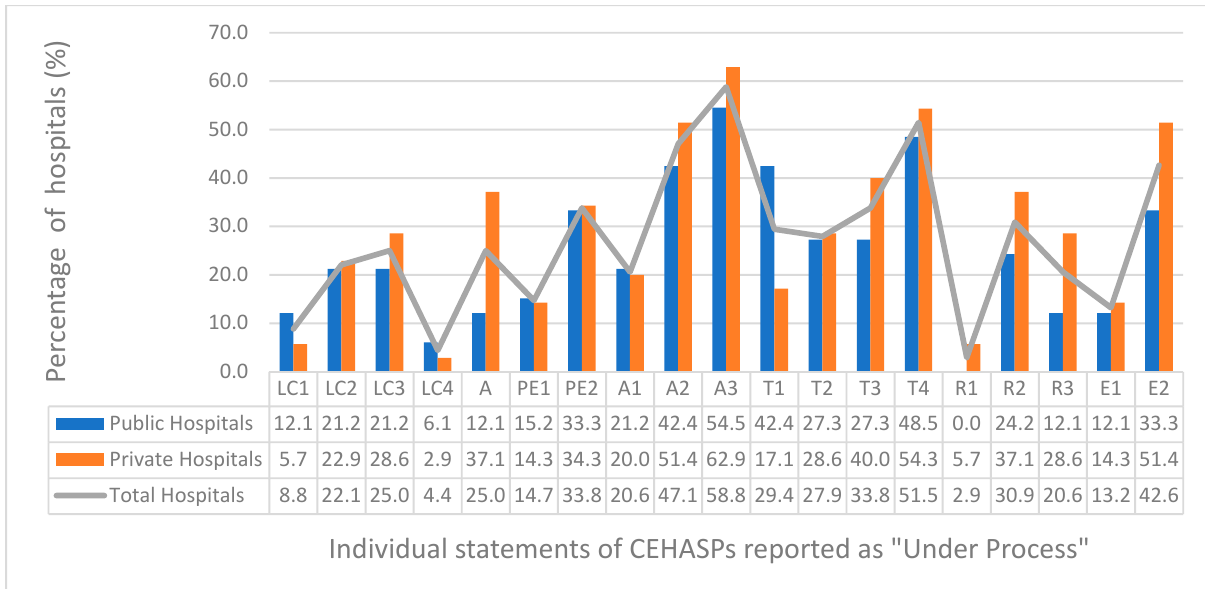
Figure 2. Percentage of hospitals which reported “Under Process” interventions for individual statements of each core element. LC1 to LC4 = statements 1 to 4 of the core element Hospital Leadership and Commitment. A = statement of the core element Accountability. PE1 to PE2 = statements 1 to 2 of the core element Pharmacy Expertise. A1 to A3 = statements 1 to 3 of the core element Action. T1 to T4 = statements 1 to 4 of the core element Tracking Antibiotics Use and Outcomes. R1 to R3 = statements 1 to 3 of the core element Reporting Antibiotics Use and Outcomes. E1 to E2 = statements 1 to 2 of the core element Education.